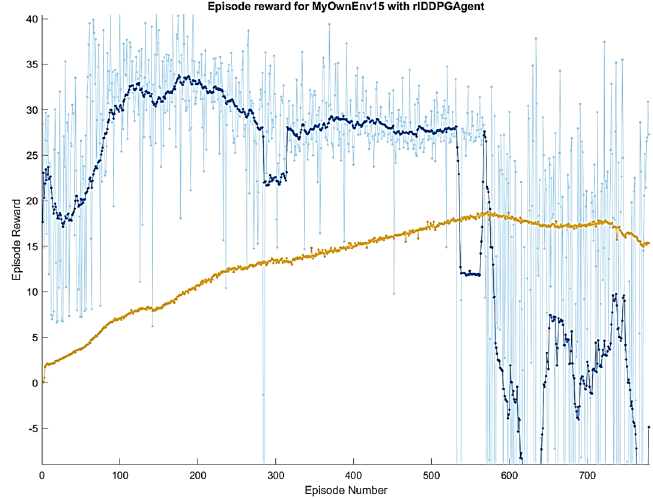
Figure 11. The episode reward graph during the training. The light blue line is the reward function. The dark blue line is the average of the reward function. The orange line is the trained critic data. It can be seen that the overfitting of the actor-critic occurred after 500 episodes.